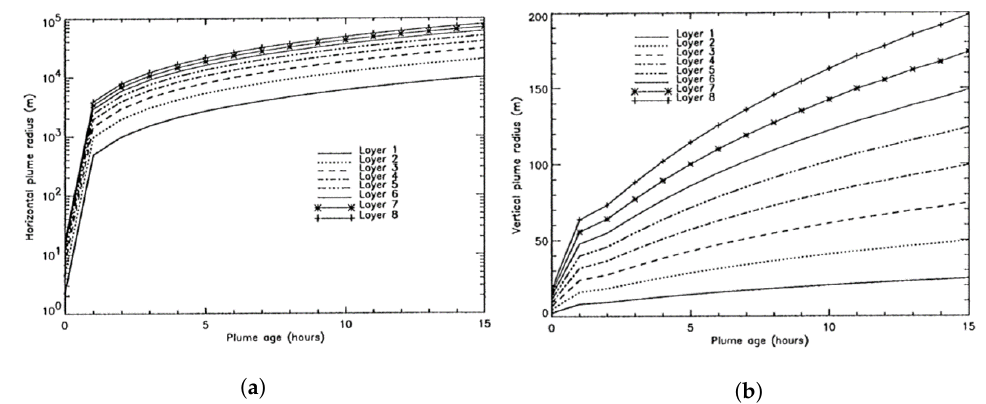
Figure 5. Evolution of ( a ) horizontal and ( b ) vertical plume radius over time, for MP model un- der assumed turbulent conditions. Reprinted with permission from Kraabøl et al. [2]. Copyright 2022,